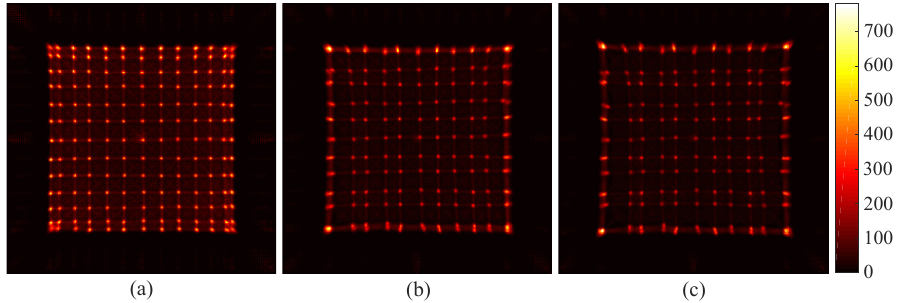
Figure 11. The flood histogram of a coupled semi-cutting light guide for 13 × 13 crystals and a SiPM array ( a ); a coupled continuous light guide for 13 × 13 crystals and a SiPM array ( b ); and directly coupled 13 × 13 crystals with a SiPM array ( c ).